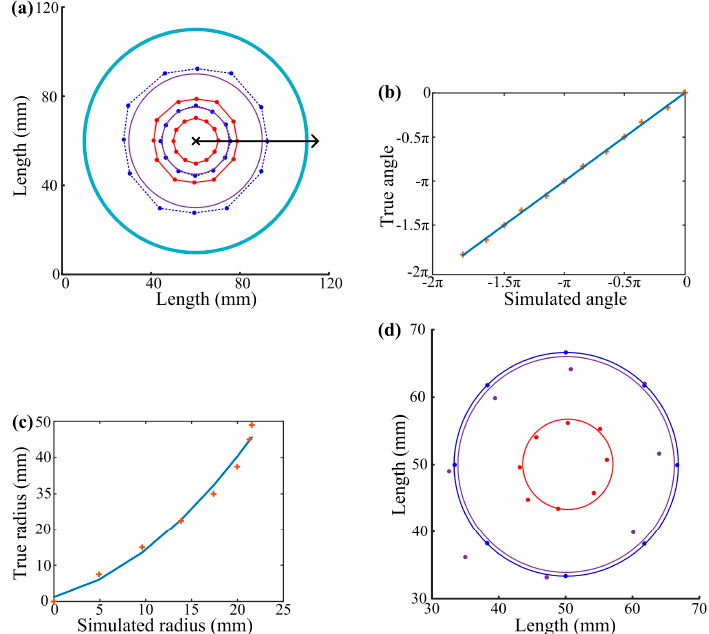
Figure 9. Touch locating of a round gel panel. ( a ) Twenty-four points were selected on a round gel panel (100 mm in diameter) along two concentric squares (60 mm and 30 mm in diameter, respectively) and their locations were simulated. Round dots represent individual points or locations, dark blue lines connect selected points, red lines connect simulated locations, purple lines indicate circles fitted with adjusted radii and angles according to Formulas (9) and (10), the light blue line indicates the physical boundary, the cross mark represents the pole of the polar coordinate system, and the black line with arrow indicates the polar axis and its direction. ( b , c ) Relationships between true and simulated angle and true and simulated radius of a touch point. Cross marks represent individual data points and blue lines indicate fitted mathematical relationships. ( d ) Touch locating experiments on a round touch panel. Round dots represent individual points or locations, the dark blue circle connects selected points, the red circle fits locations calculated with Formula (7), and the purple circle fits locations from Formulas (9) and (10).